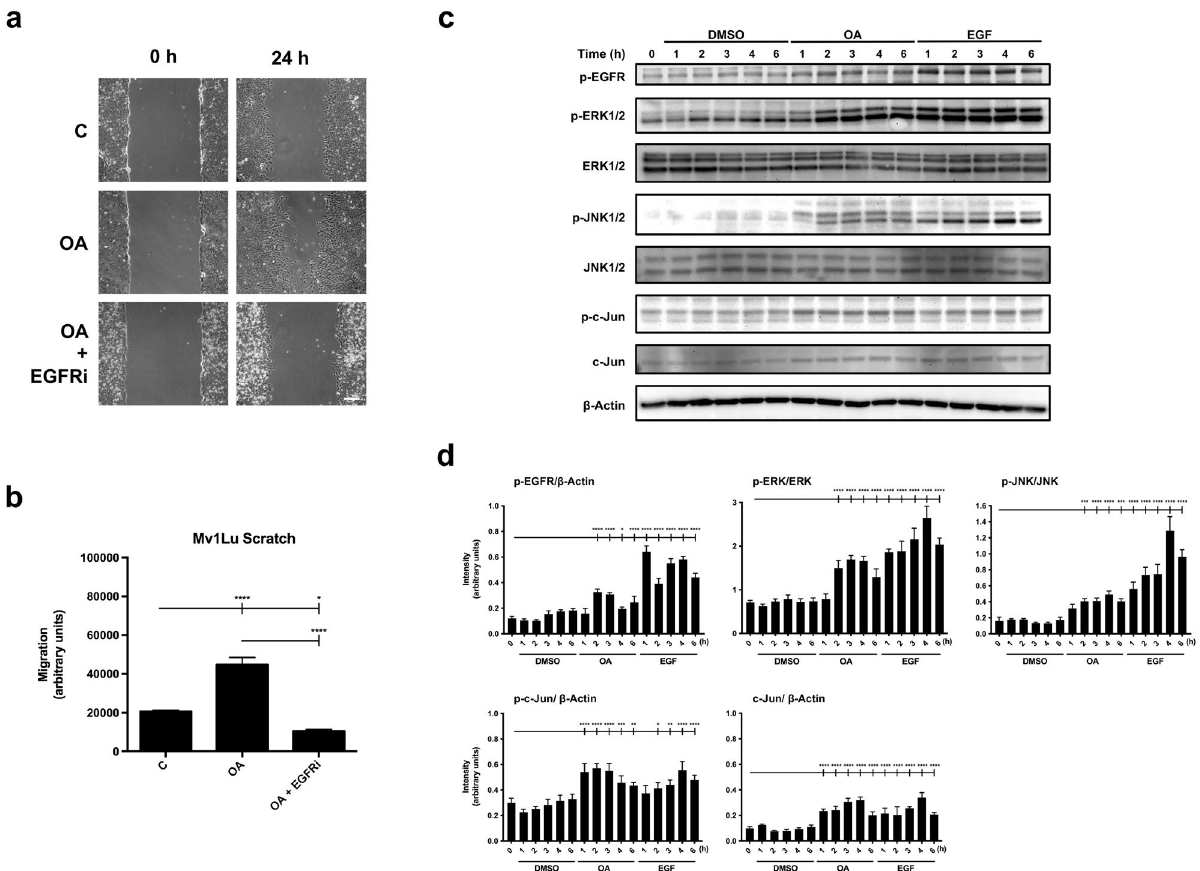
Figure 3. C-Jun and EGFR OA activation, necessary for OA-cell migration, are decoupled in Mv1Lu cells. ( a ) The figure shows representative images of cell migration obtained under control conditions compared to those with 5 µM OA and OA plus 2,5 µM EGFRi after 24 h treatment. Scale bar 200 µm. ( b ) Plot represents cell migration as the difference obtained between the quantified areas at time 0 h and time 24 h in each condition. Asterisks indicate statistically significant differences between the selected conditions according to a one-way ANOVA statistical analysis: (*p < 0.05, **p < 0.005, ***p < 0.001 and ****p < 0.0001). ( c ) Total protein extracts from serum-starved sub-confluent Mv1Lu cells treated with 5 µM OA, EGF or DMSO equivalent volume as vehicle control. Different protein phosphorylation was assayed at the indicated times (h) targeting phospho- EGFR (Tyr 1068), phospho-ERK1/2 (Thr 202/Tyr 204), phospho-JNK1/2 (Thr 183/Tyr 185) and phospho-c-Jun (Ser 63). Additionally, total protein expression was assayed: ERK1/2, JNK1/2 and c-Jun. β-Actin was used as a loading control. A representative experiment is shown. ( d ) Plots with intensity values of each protein assayed by Western-blot, by gathering the data of three independent experiments. Asterisks indicate statistically significant differences between the selected conditions according to a one-way ANOVA statistical analysis: (*p < 0.05, **p < 0.005, ***p < 0.001 and ****p <